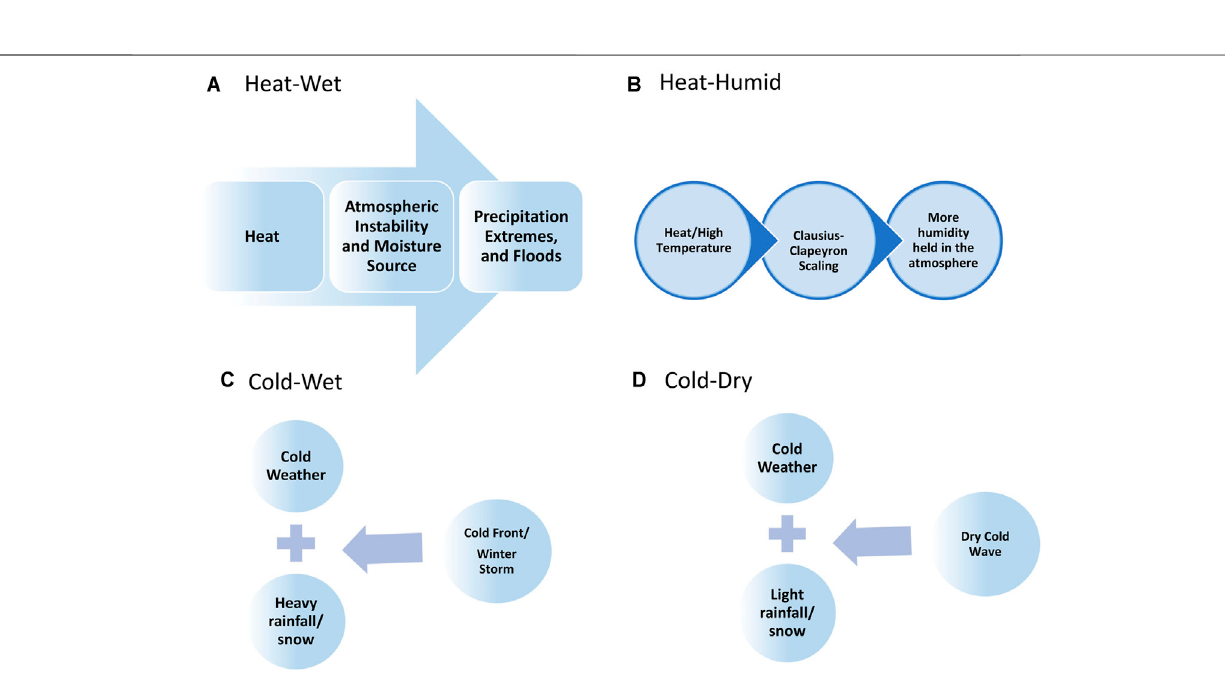
Frontiers in Earth Science |